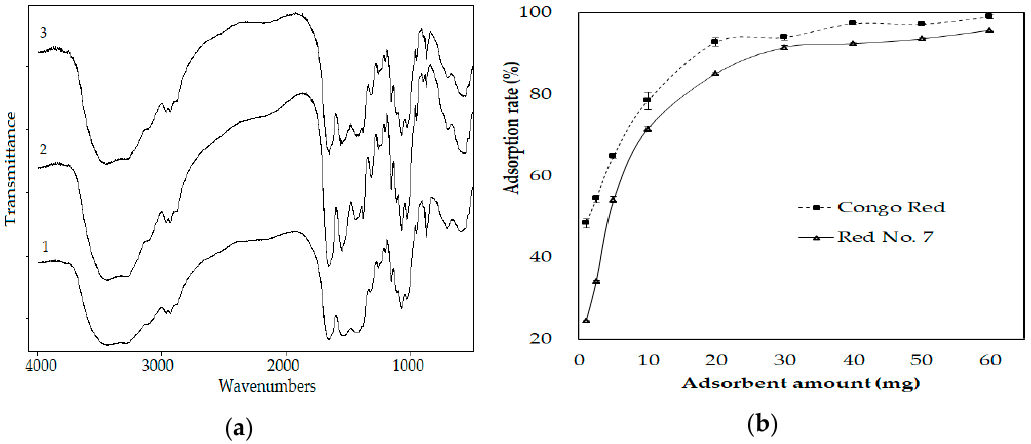
Figure 7. Effect of the chitin amount on the adsorption of Congo Red and Red No. 7 ( a ), and Fourier-transform infrared spectroscopy (FTIR) profiles of chitin before and after adsorbing the dyes ( b ). 1, chitin; 2, chitin after adsorbing Congo Red; 3, chitin after adsorbing Red No. 7. The error bar represents the standard deviation of three repetitions.